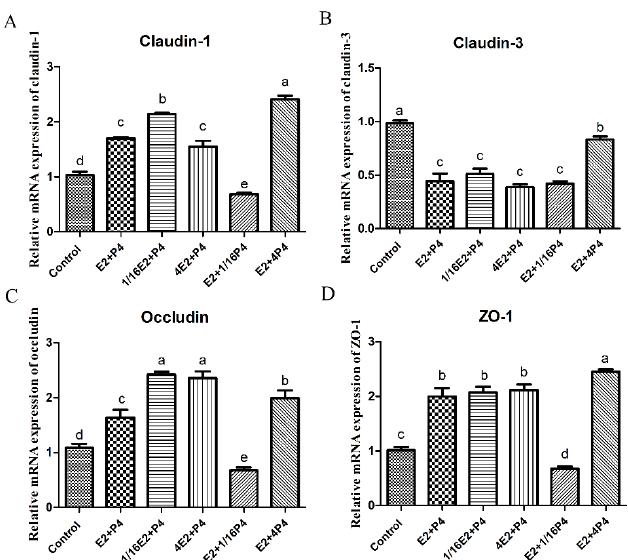
Figure 3. The effect of the E 2 and P 4 treatment on the mRNA expression of claudin-1, claudin-3, occludin, and ZO-1. ( A ) Claudin-1 mRNA expression. ( B ) Claudin-3 mRNA expression. ( C ) Occludin mRNA expression. ( D ) ZO-1 mRNA expression. These experiments were repeated at least three times. Data are represented as means ± SD; the values with different letters differed signifi- cantly ( p < 0.05).